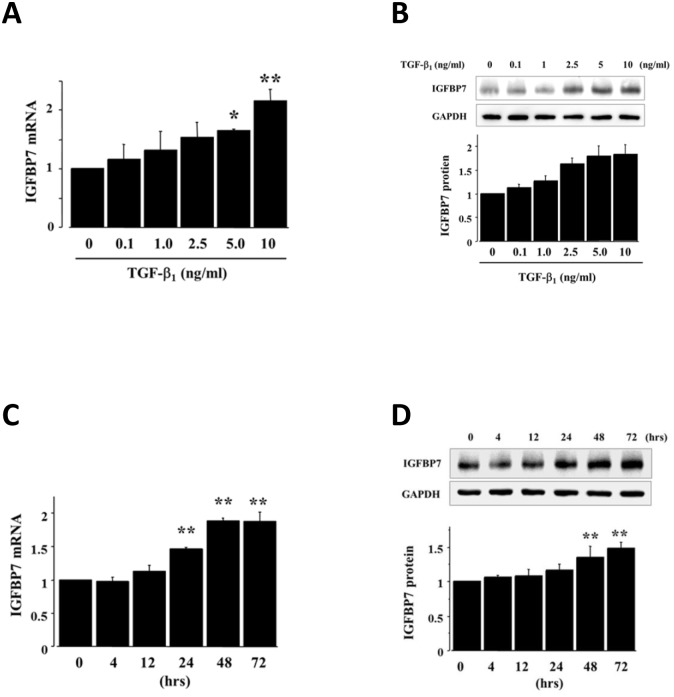
TGF-β1 induced IGFBP7 expression in HRPTECs.HRPTECs were incubated for 48 h with the indicated concentrations of TGF-β1 in serum-free medium. IGFBP7 mRNA expression was determined by real-time RT-PCR (A). The expression of IGFBP7 was normalized to that of GAPDH in the same cell extracts. The expression of IGFBP7 protein in the cell lysates was evaluated by a Western blot analysis (B). The amounts of IGFBP7 were analyzed by western blotting. GAPDH was used as a loading control. The representative immunoblot shows the expression of IGFBP7. TGF-β1 dose-dependently enhanced the expressions of IGFBP7 mRNA (A) and protein (B) in the HRPTECs. The treatment of HRPTECs for the indicate times with 2.5 ng/ml TGF-β1 showed a time-dependent increase of IGFBP7 mRNA (C) and protein expression (D). Each bar represents means ± SD of three separate experiments. *p<0.05 vs. control, **p<0.01 vs. control.